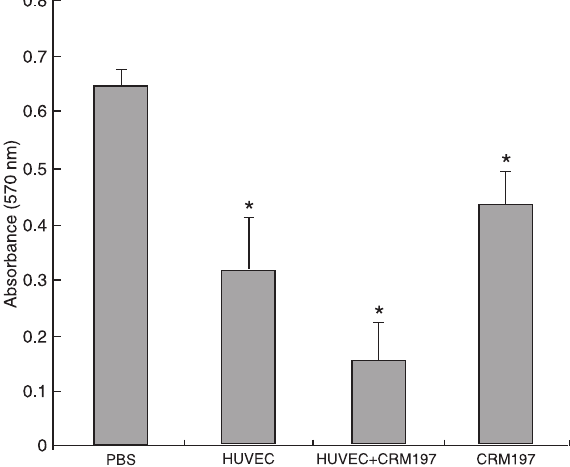
Figure 4. Effect of immune sera on HUVEC proliferation. Immune sera isolated from viable HUVEC+CRM197-immunized mice had the strongest ability to inhibit the proliferation of HUVECs in vitro . Immune sera (10 μL) from immunized groups and guinea pig sera (10 μL) were added to the HUVEC culture medium in a final volume of 120 μL/well. Except for the PBS groups, all the immu- nized sera showed significant inhibition against the proliferation of HUVECs in vitro . Moreover, sera from the HUVEC+CRM197 group had the strongest inhibitory ability against the proliferation of HUVECs in vitro . The bars denote absorbance values at 570 nm. HUVECs = human umbilical vein endothelial cells; CRM197 = nontoxic diphtheria toxin. *P < 0.01 compared to control (Stu- dent t -test). Data are reported as means ±